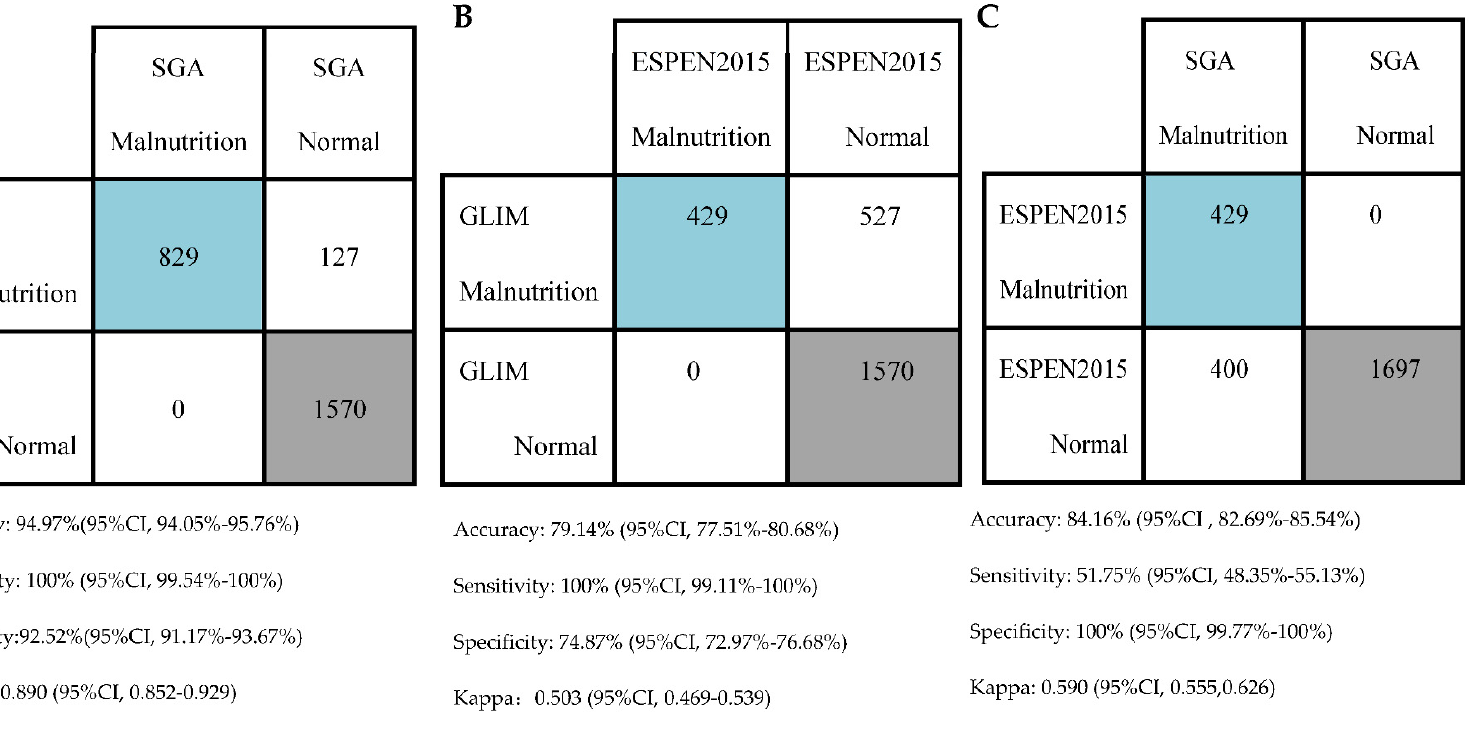
Figure 2. Diagnostic consistency between the criteria. ( A ) Consistency between GLIM and SGA. ( B ) Consistency between GLIM and ESPEN 2015. ( C ) Consistency between ESPEN 2015 and SGA. GLIM, Global Leadership Initiative on Malnutrition; SGA, subjective global assessment; ESPEN 2015, the 2015 consensus statement by the European Society for Clinical Nutrition and Metabolism.